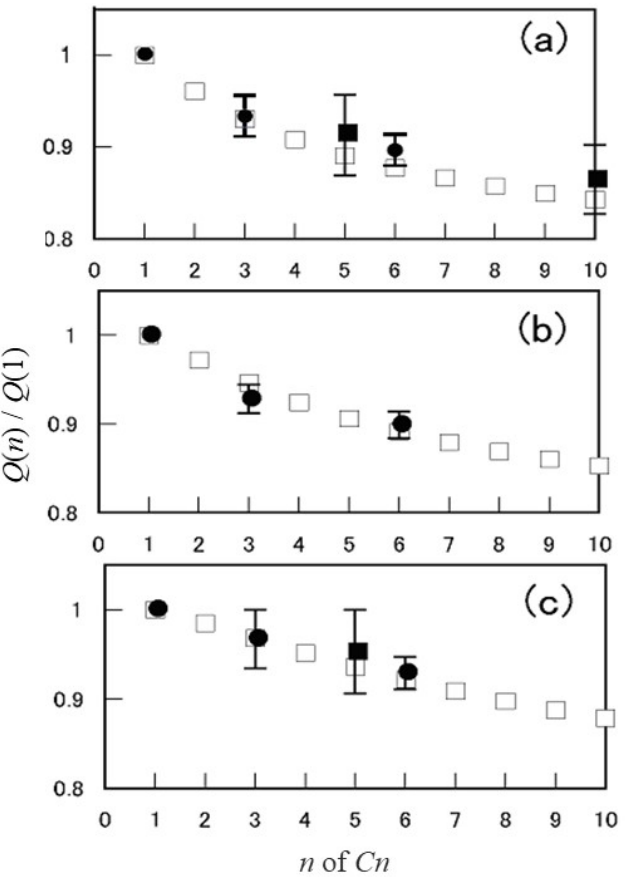
Figure 9. Average charge ratio Q ( n ) / Q ( 1 ) calculated for 1 MeV/atom C n ( n = 1 − 10 ) ions in linear-chain structure penetrating carbon foil of ( a ) 5 μ g/cm 2 ( b ) 8 μ g/cm 2 ( c ) 15 μ g/cm 2 . Calculated results ( □ ) with the experimental data ( ● [52], ■ [13]) [15].